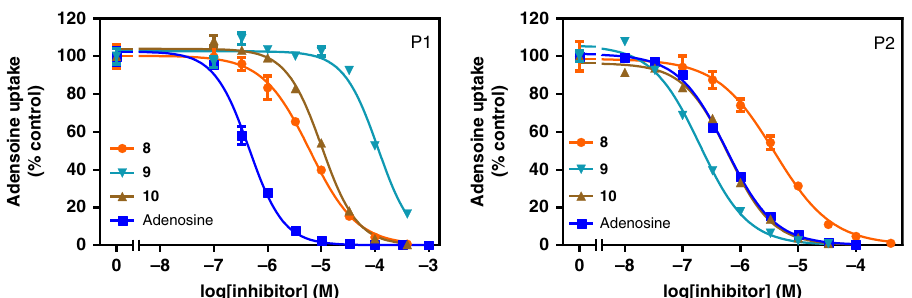
Fig. 5 Transport of [ 3 H]adenosine via P1 and P2 transporters in the presence nucleoside analogues. Uptake of [ 3 H]adenosine was measured in the presence of increasing concentrations of nucleoside analogues 8 , 9 and 10 . Inhibition plots of adenosine and its analogues versus P1- or P2-mediated [ 3 H] adenosine transport. The graphs represent one representative out of three independent experiments ( n = 3), each performed in triplicate. Error bars are SEM, which fall within the symbol when not shown. Source data are provided as a Source Data fi le.